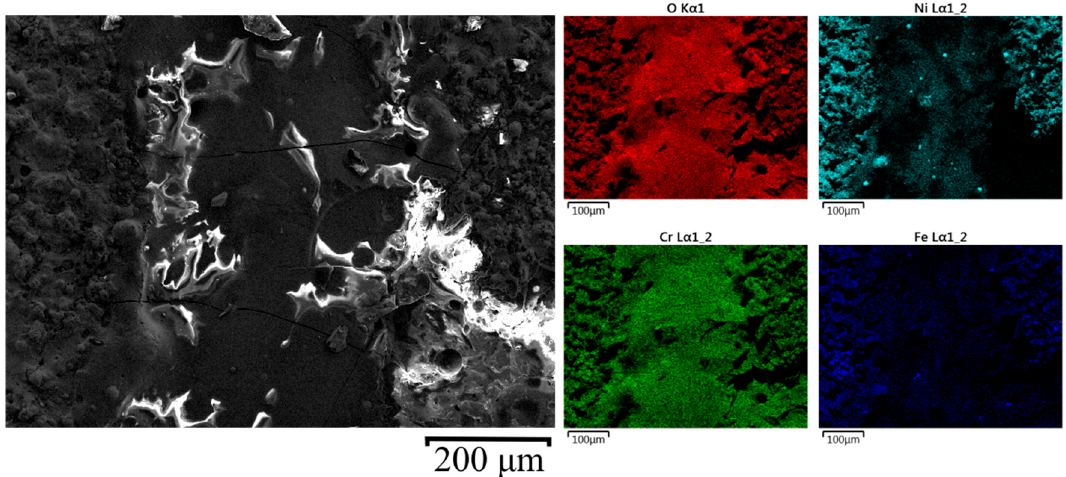
Figure 9. An EDX image of a laser-ablated line on the film surface.